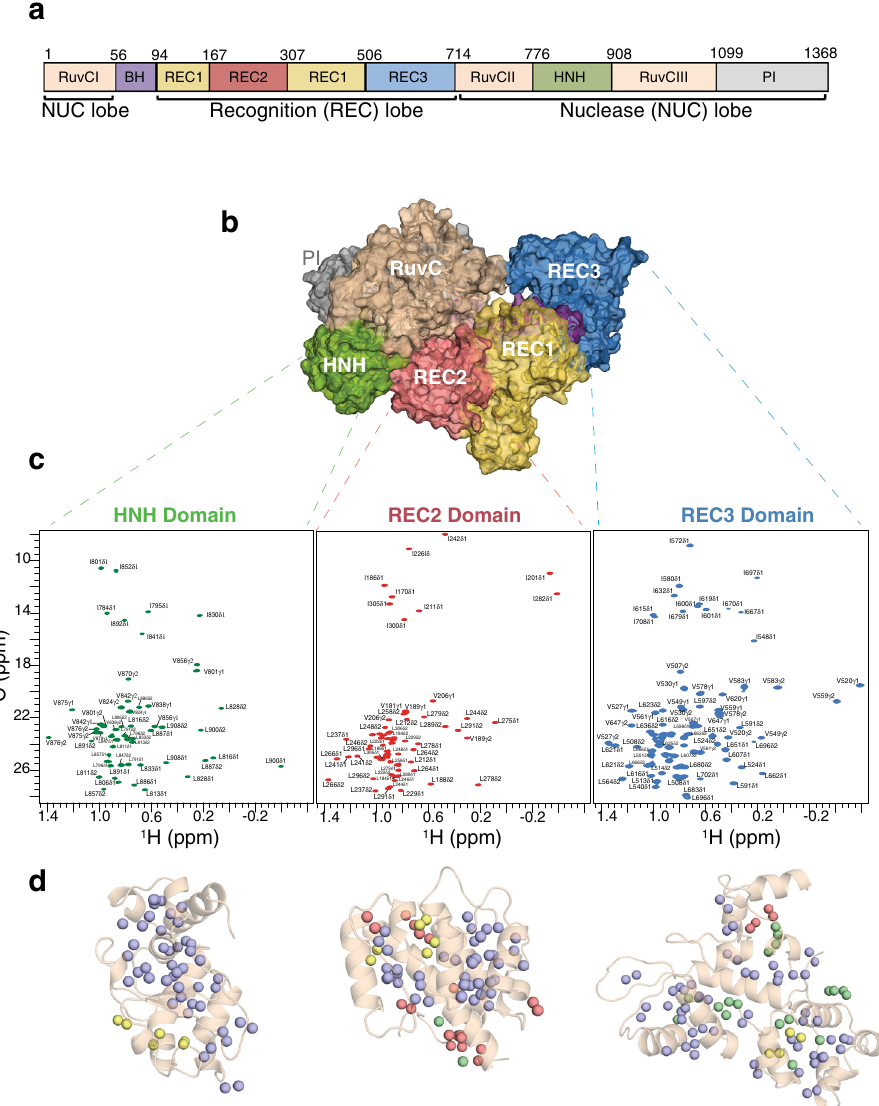
Fig. 4 Streamlined resonance assignments of Cas9 domains using MAUS. a Domain organization of Spy Cas9 composed of the recognition lobe (REC) and nuclease lobe (NUC). BH, bridge helix; PI, PAM-interacting. b Surface representation of SpyCas9 (PDB ID 4cmp) depicting the bilobed architecture. Protein domains are colored as in a . c Single domains used in the divide-and-conquer approach. 1 H- 13 C HMQC spectra of selectively labeled HNH (green), REC2 (red), and REC3 (blue) domains at Ile δ 1 - 13 CH 3 ; Leu, Val- 13 CH 3 / 13 CH 3 positions, acquired at 800 MHz, 25 °C. The spectra of the individual domains of Cas9 indicate that they retain their proper fold when in isolation. d Number of valid assignment options for each residue identi fi ed by MAUS for HNH, REC2, and REC3, respectively. The colored spheres represent fi nal valid resonance assignment options: violet (1 option), green (2 options), yellow (3 options), and red (>3